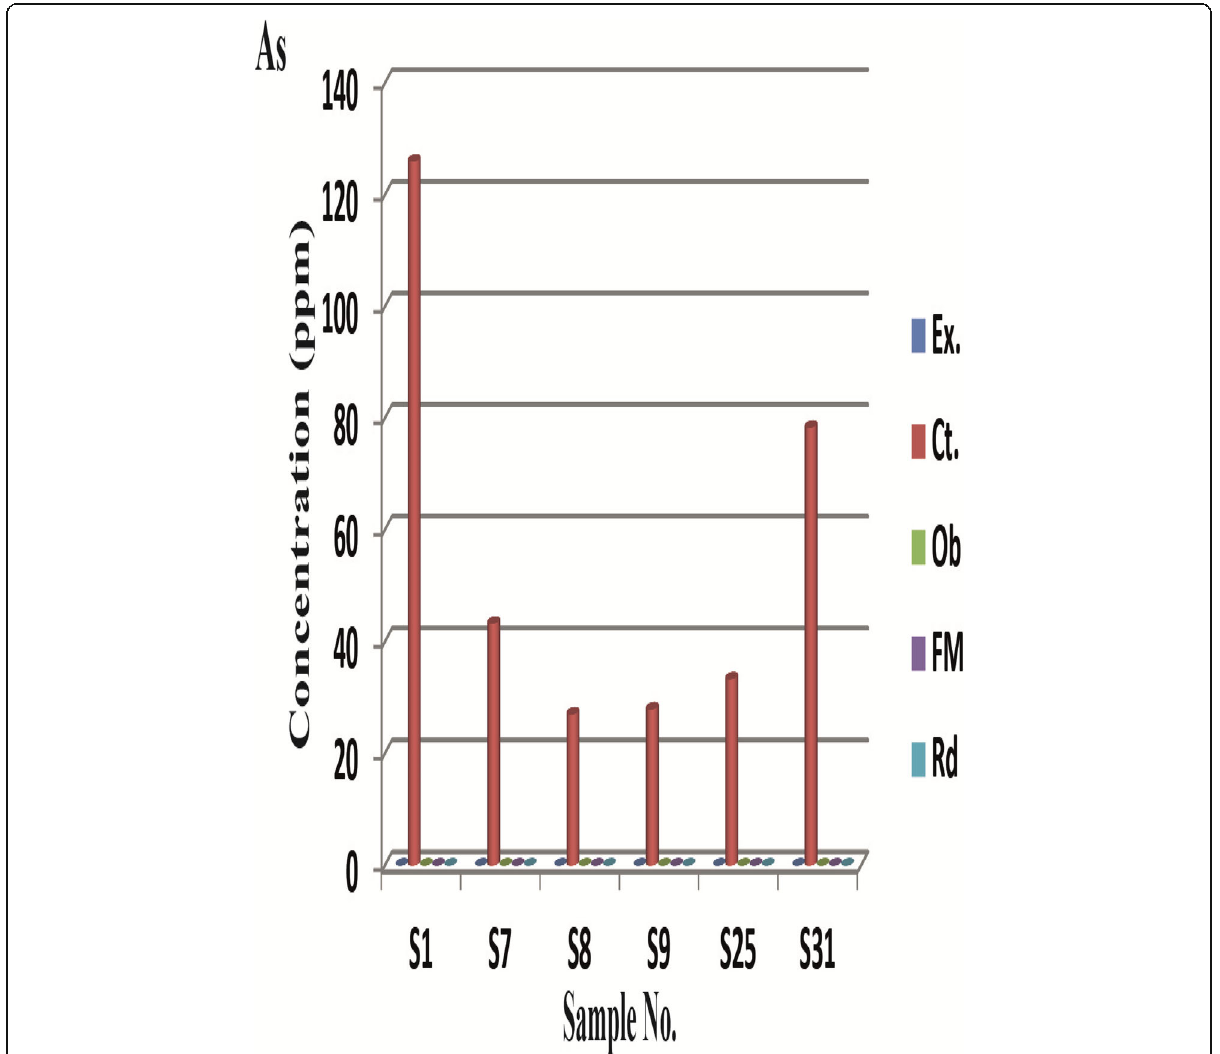
Fig. 4 Relative distribution of As among the various soil fractions in the study area